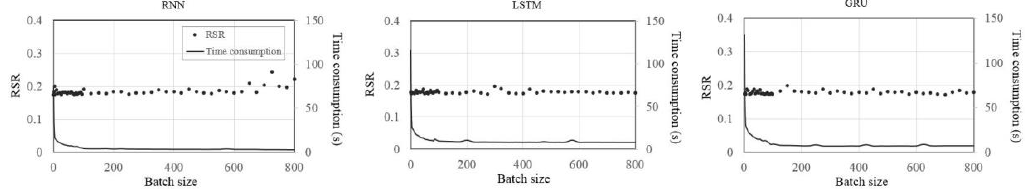
Figure 8. The influence of batch size on model performance.